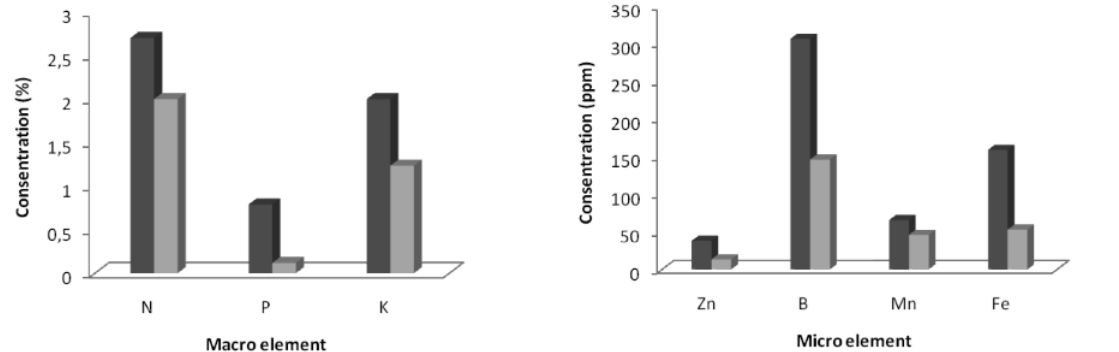
Figure 2. Consentration of nurtetional elements in pistachio leavs. Black and gray columns stand to sprayed and control trees respectively